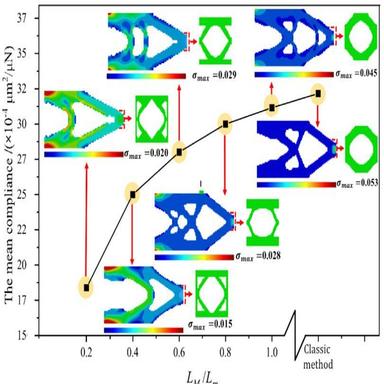
Influence of LM/Lm on the structural stress nephogram for case 1.